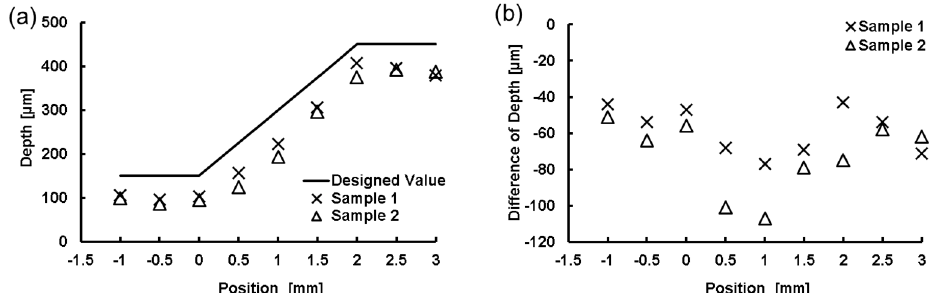
Figure 9. Measurement of microchannel depth. ( a ) Full thickness profiles of the designed and fabricated microchannels. Position zero is the inclination starting point; ( b ) Distributions of deviations of fabricated depth calculated by subtracting each fabricated value from the design value.